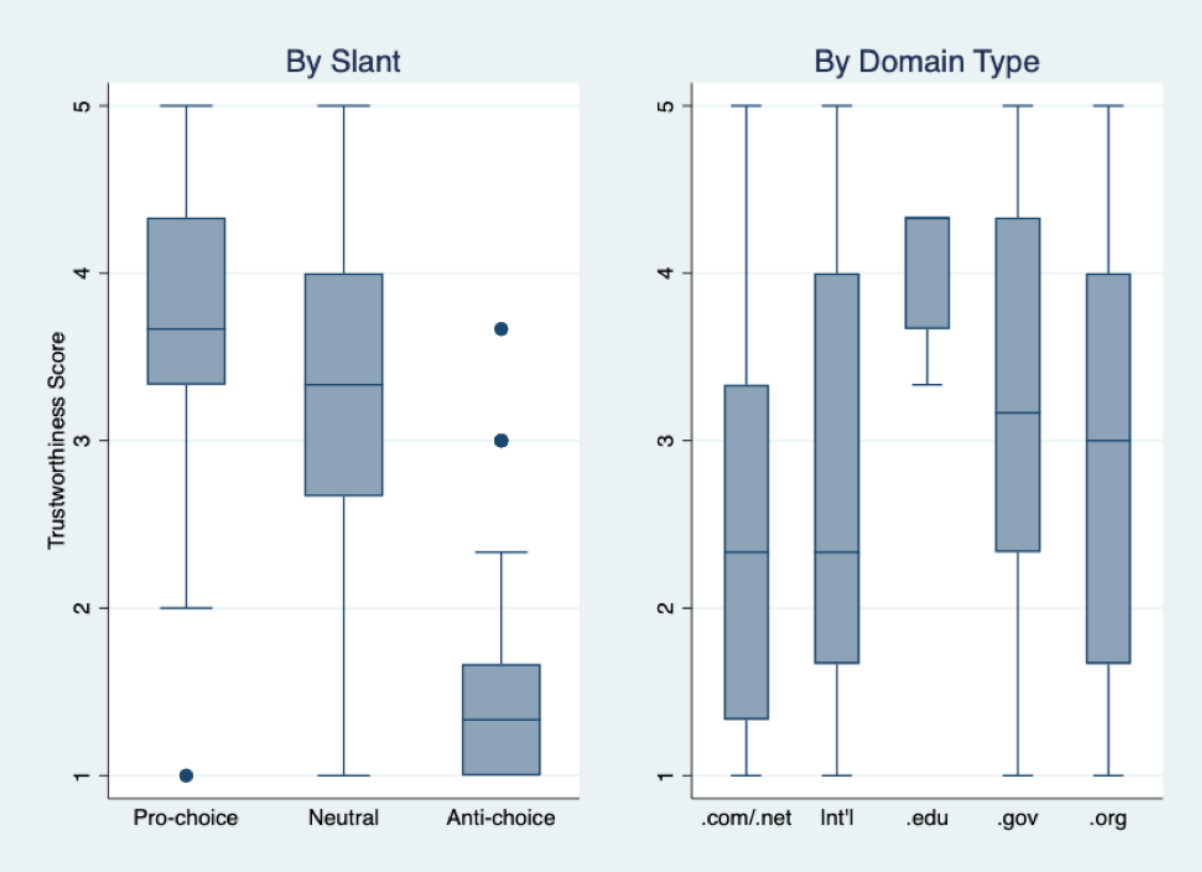
Figure 3. Box-and-whisker plots comparing trustworthiness of online abortion resources by slant and domain type (n=316). Trustworthiness was scored on a scale of 1 (least trustworthy) to 5 (most trustworthy). The central line in each box marks the median trustworthiness score; upper and lower box edges mark the 75th and 25th percentile, respectively; whiskers indicate 150% of the interquartile range and outliers are shown as individual points. Int’l: international domain (eg, .uk, .nz,